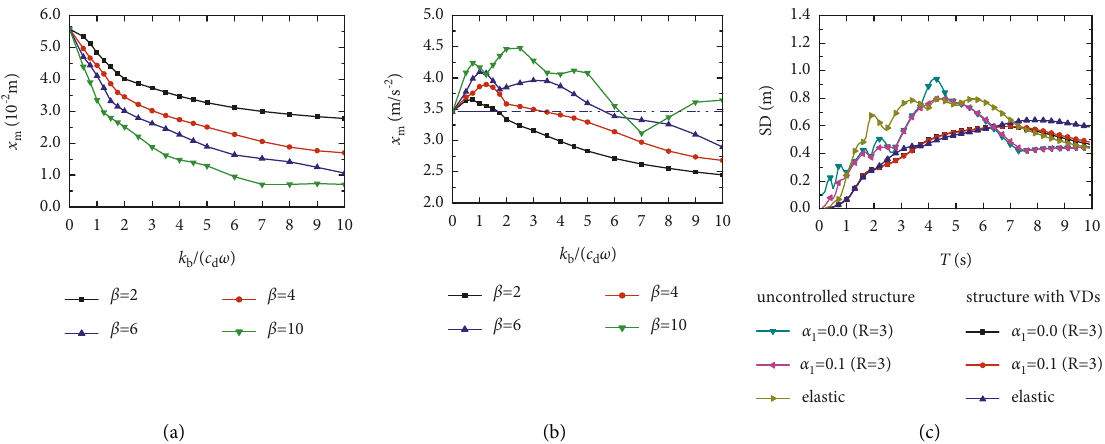
Figure 5: The seismic response of the SDOF structure with the different values of β : (a) the displacement of ETD; (b) the acceleration ratios of ETD; (c) the displacement response spectra of the uncontrolled structure and the structure with